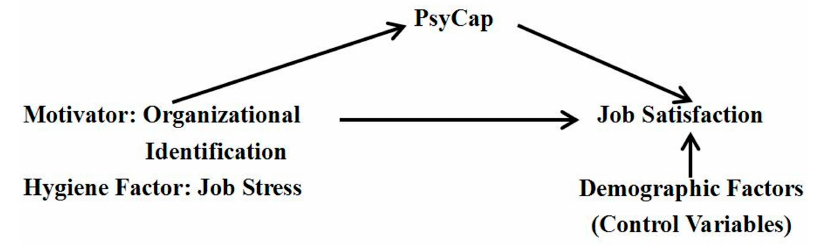
Figure 1. Conceptual framework of this study. Note: PsyCap: psychological capital.